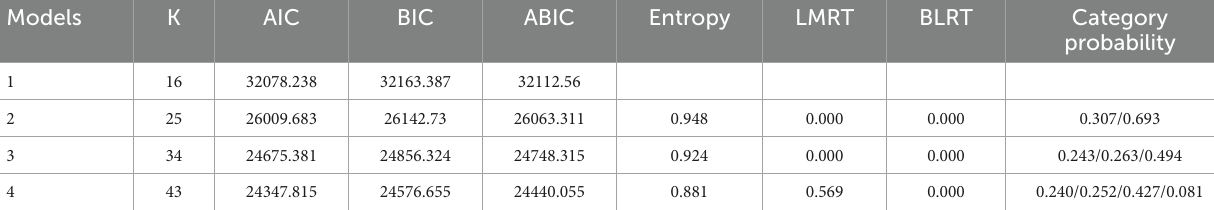
TABLE 2 Latent profile model fit indicators for high school students’ sense of hope types.